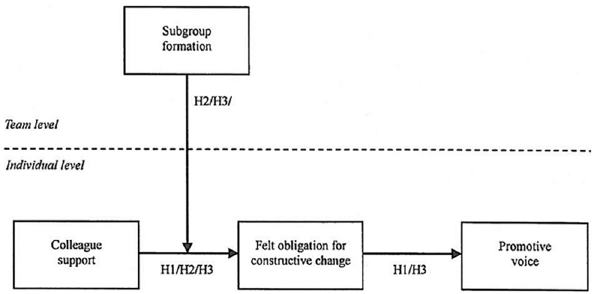
Fig 1. Hypothetical model. H1 represents an indirect effect. H2 represents a cross-level moderation effect. H3 represents a cross-level moderated mediation effect. H = Hypothesis.